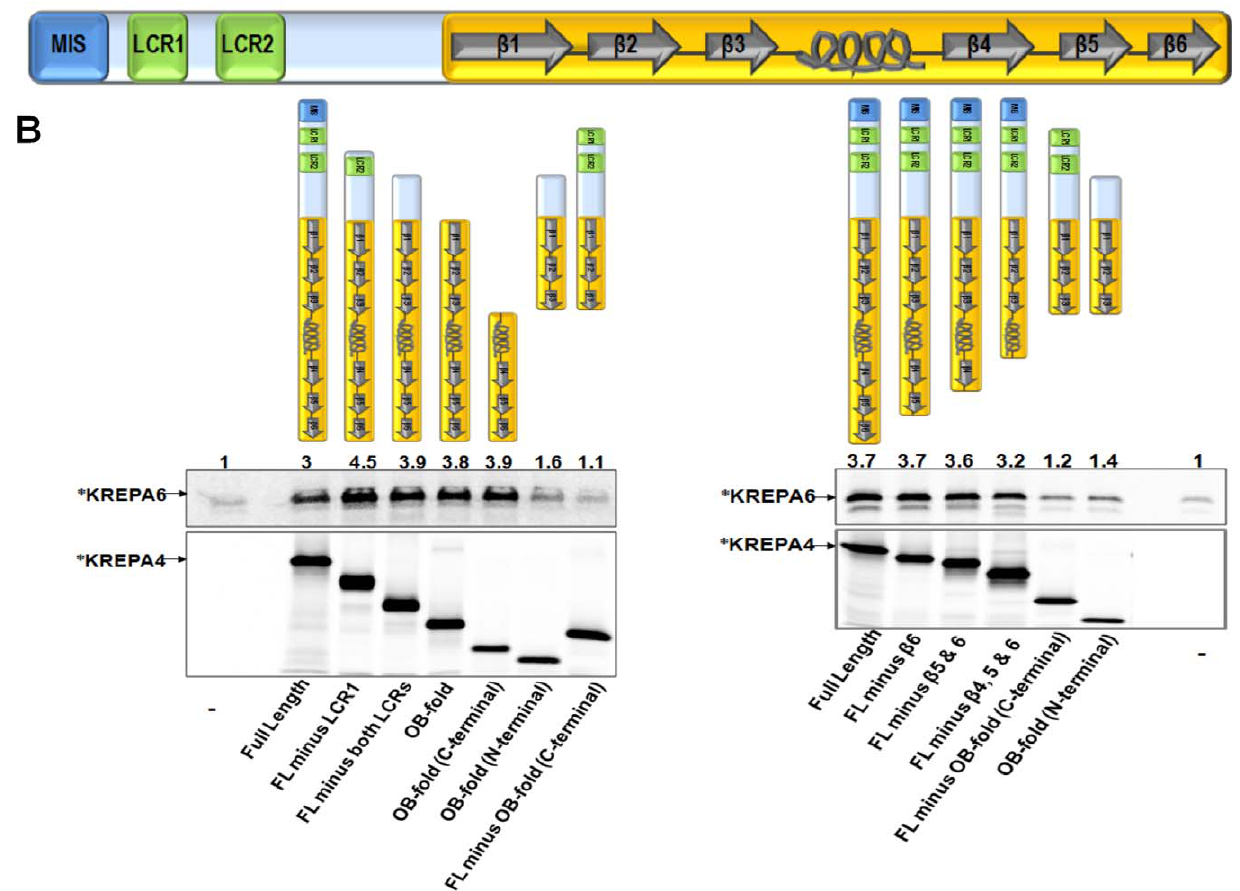
Figure 1. a -helix of KREPA4 OB-fold mediates the interaction with KREPA6. (A) Complete amino acid sequence of KREPA4 is shown, with the putative mitochondrial import signal (MIS) sequence highlighted in blue, the predicted low compositional complexity regions (LCRs) in green, and the predicted OB-fold in yellow. The predicted secondary structure of KREPA4 is denoted below the primary amino acid sequence. H stands for a helix, E for b strand, and C for coiled regions. The domain structure of the full length protein is represented schematically; the predicted secondary structure of the OB-fold has been indicated, where arrows represent b strands and the spiral represents the a -helix. (B, Upper left & right panels ) CoIP of 35 S-methionine labelled (*) KREPA6 in the presence of the indicated, unlabelled full length or truncated KREPA4 proteins, also represented schematically. An antibody against the Xpress tag on KREPA4 constructs was used for immunoprecipitation. Numbers indicate the level of co- immunoprecipitated KREPA6 relative to the background, which is normalized to 1. Lanes marked with ( 2 ) in the bottom panels show the level of KREPA6 retained by non-specific binding to the beads, in the absence of KREPA4. (B, Lower left & right panels ) Equimolar amounts of 35 S-methionine labelled (*) KREPA4 constructs present in the CoIP are shown. When both proteins were present together, only one was radiolabelled at a time, as indicated.